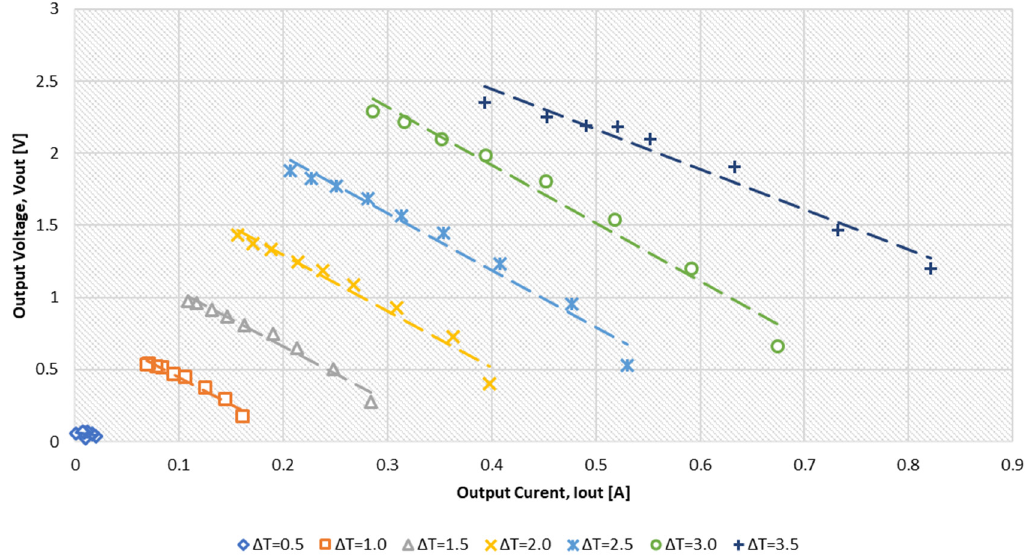
Table 3. Calculated parameters for TEC1-12722.